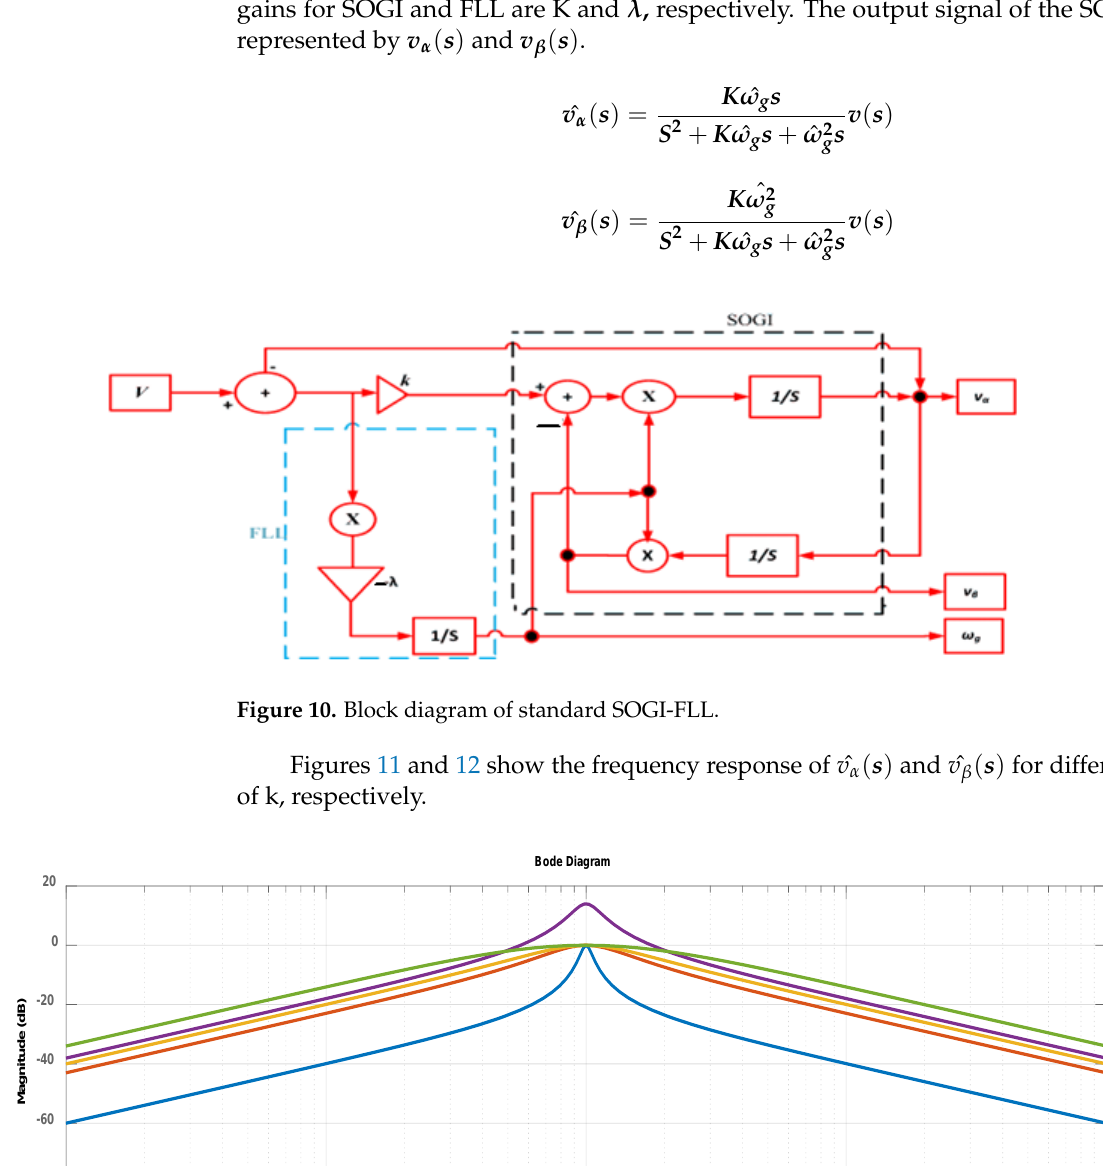
Figure 9. Block diagram of enhanced SRF SOGI-FLL controller [34].